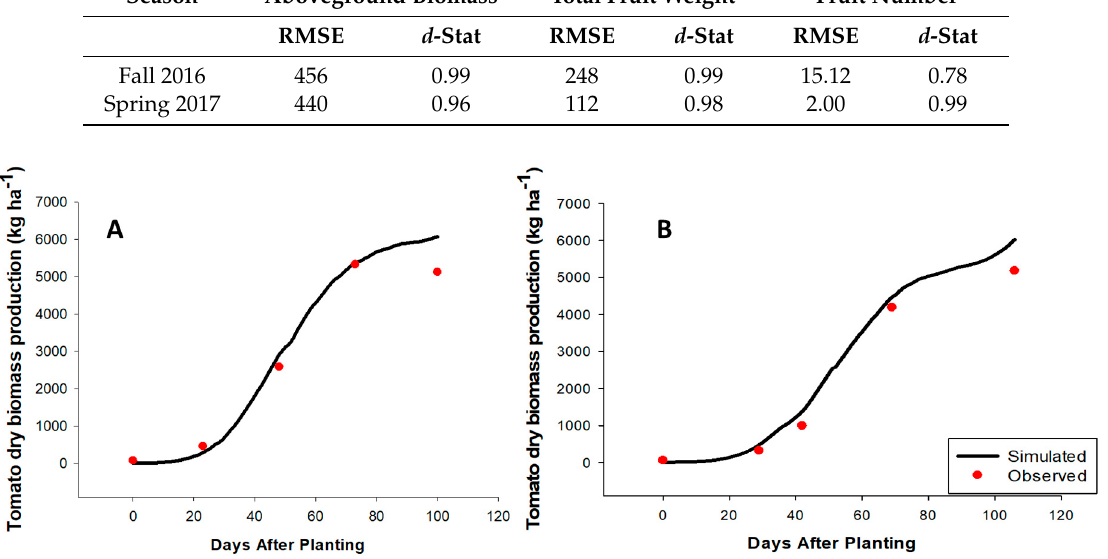
Table 4. Root ‐ mean ‐ square error (RMSE) and Willmott d index ( d ‐ Stat) for biomass production, fruit weight, and fruit number after calibration.